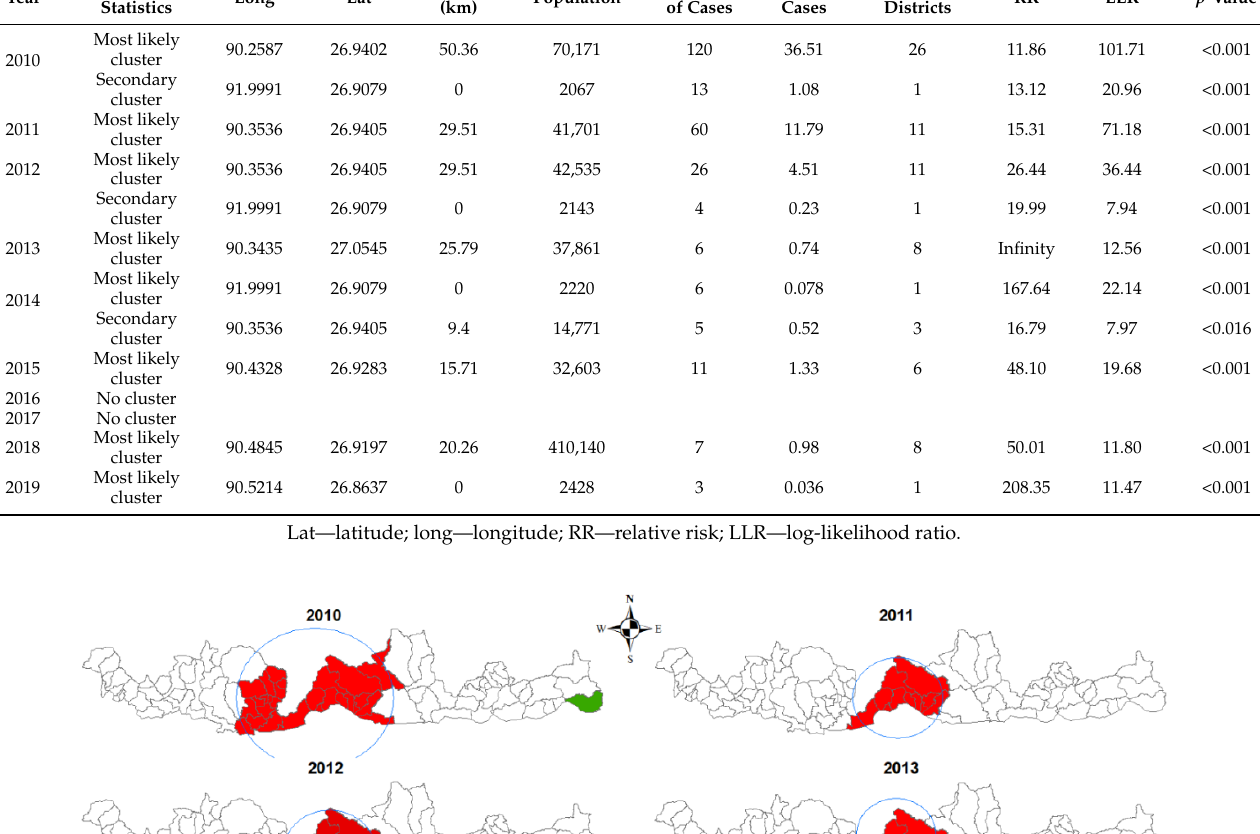
Table 2. Spatial clusters of Plasmodium falciparum in Bhutan, 2010–2019.